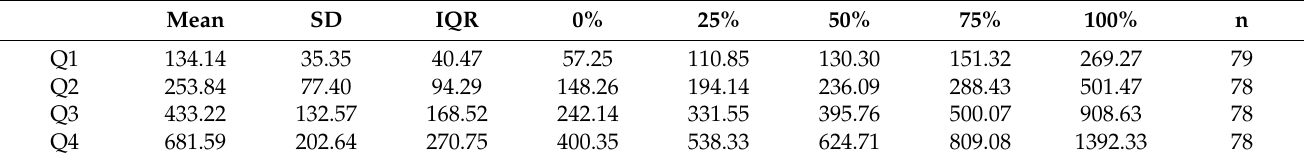
Table 6. Aging Index (people aged 65 or over for every 100 under 20). Sources: own elaboration based on data from the Galician Institute of Statistics IGE, Municipal Register of Inhabitants, the year